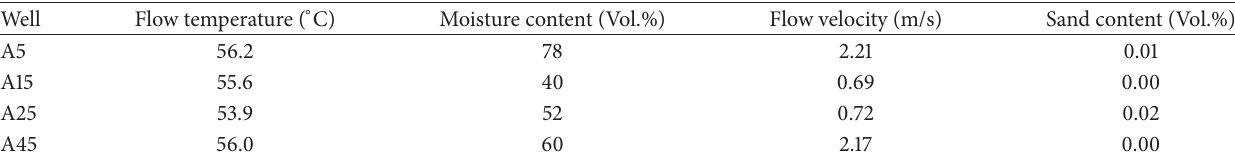
Table 1: Major parameters of test